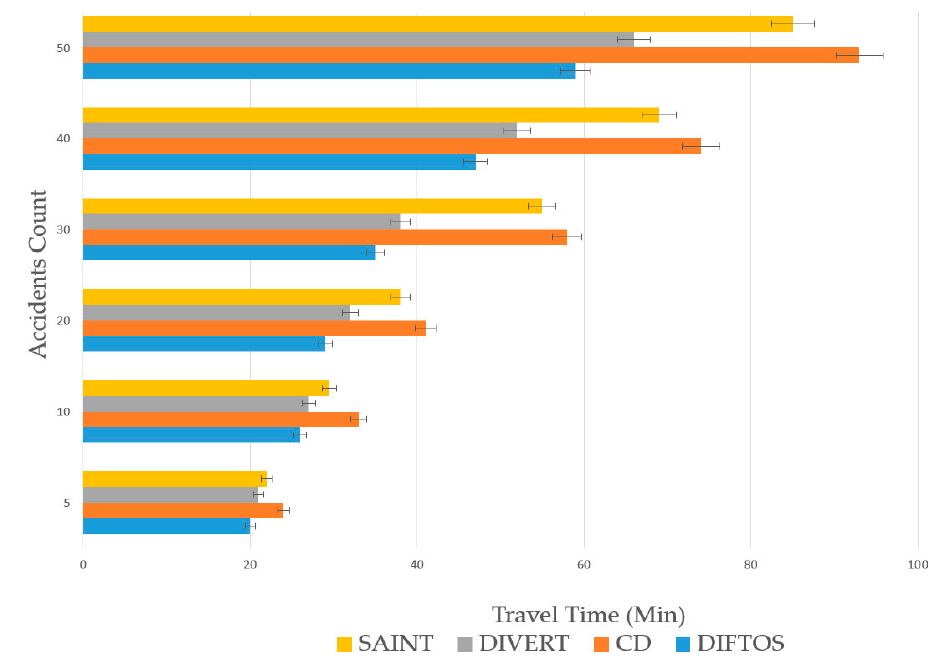
Figure 10. Accident count vs. travel time.